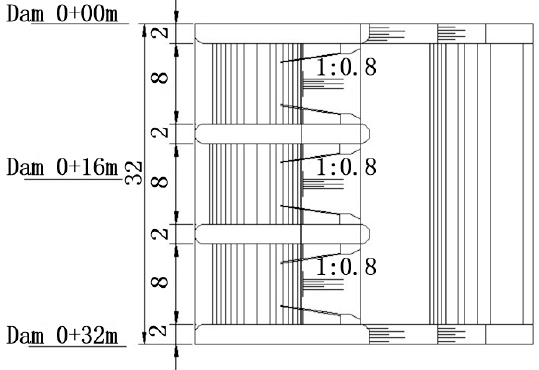
Figure 7. Plane view of the overflow dam section (unit: m).